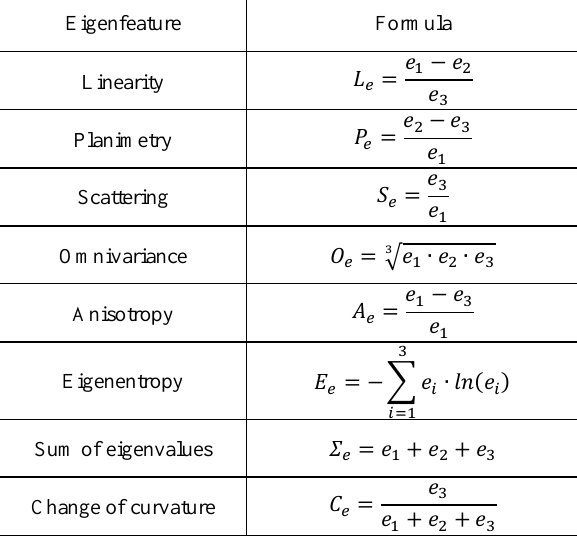
Table 1. Eigenfeatures mathematical